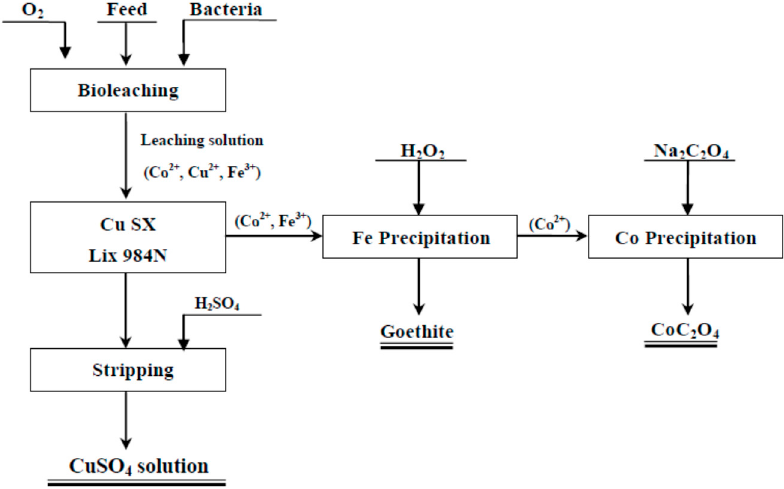
Figure 1. Flow sheet for the recovery of cobalt from cobalt tailings using the bioleaching method and selective sequential extraction technologies.